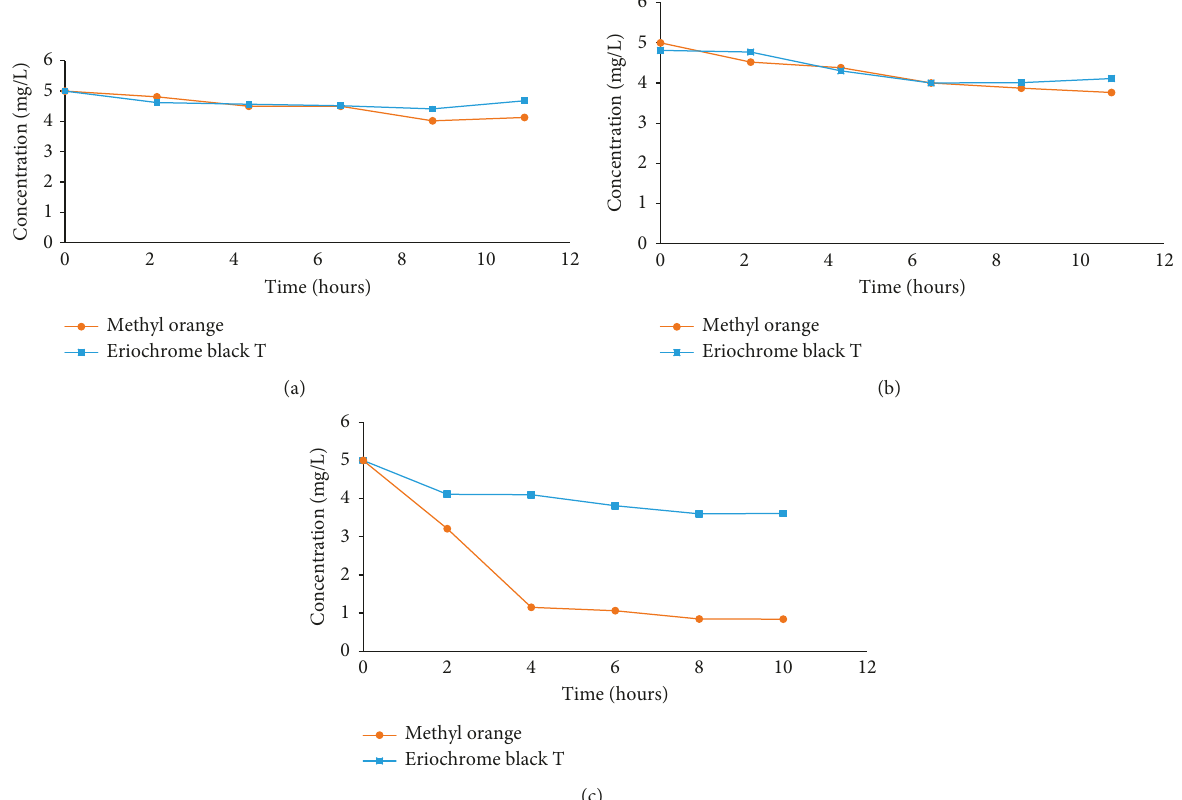
Figure 5: Time-dependent adsorption kinetics of Eriochrome Black T and methyl orange on the clay samples. (a) E1, (b) E2, and (c)